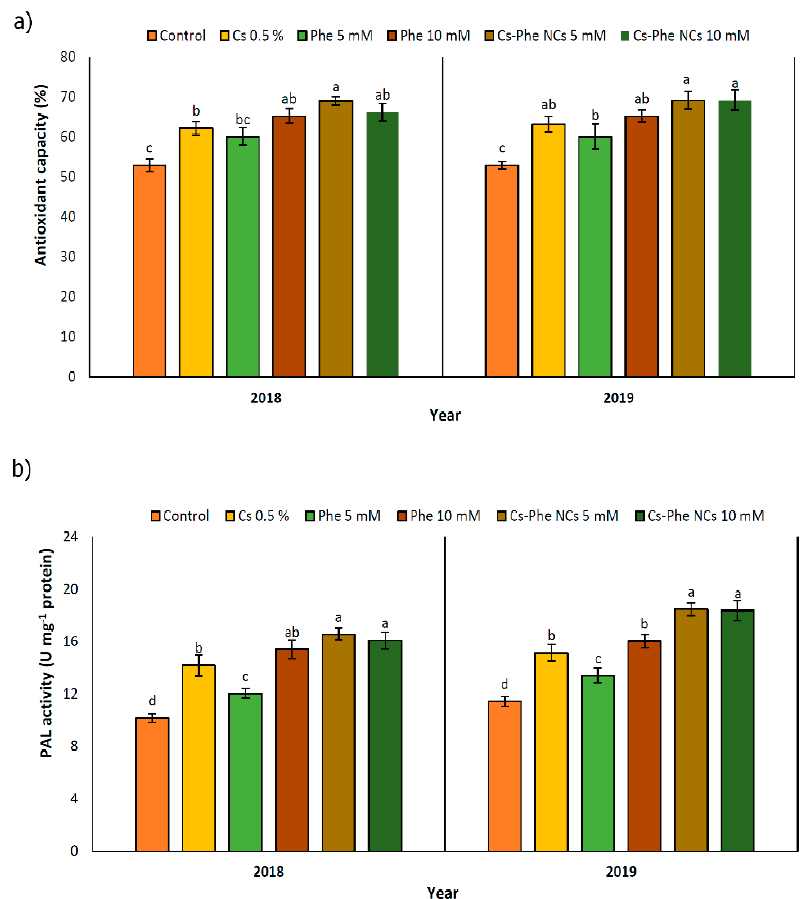
Figure 6. Effect of 0 (control), CS (0.5%), Phe (5 and 10 mM), and CS–Phe NCs (5 and 10 mM) on antioxidant capacity ( a ) and PAL activity ( b ) of V. vinifera cv. Flame Seedless berries. The SDs denoted by lowercase letters in the same treatment indicate significant differences at p < 0.05 according to Duncan’s test.